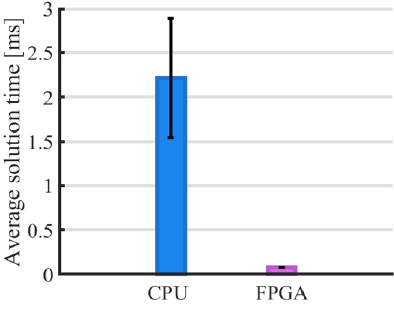
Figure 10 Comparison of the solution time of CPU and FPGA